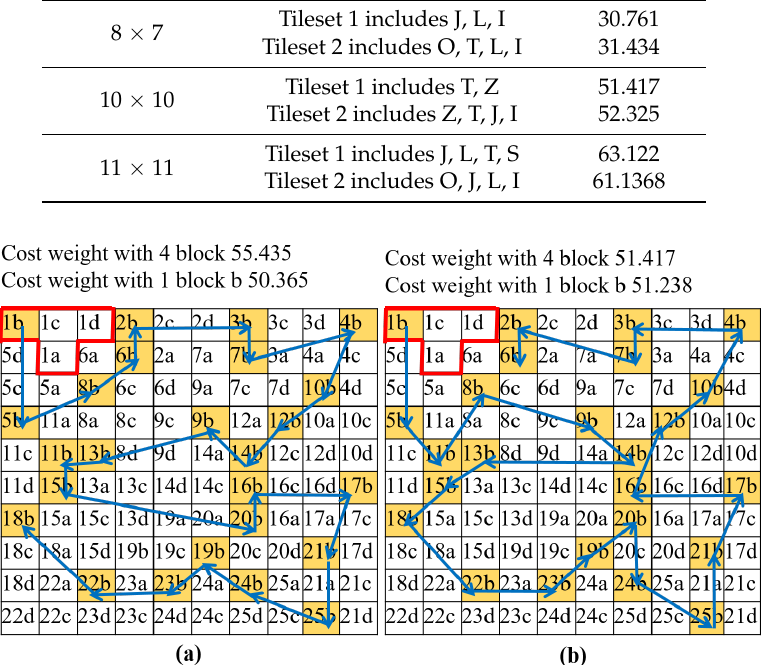
Figure 15. Paths generation for hTetro. ( a ) Path considering only block b ; ( b ) Path considering all four blocks.